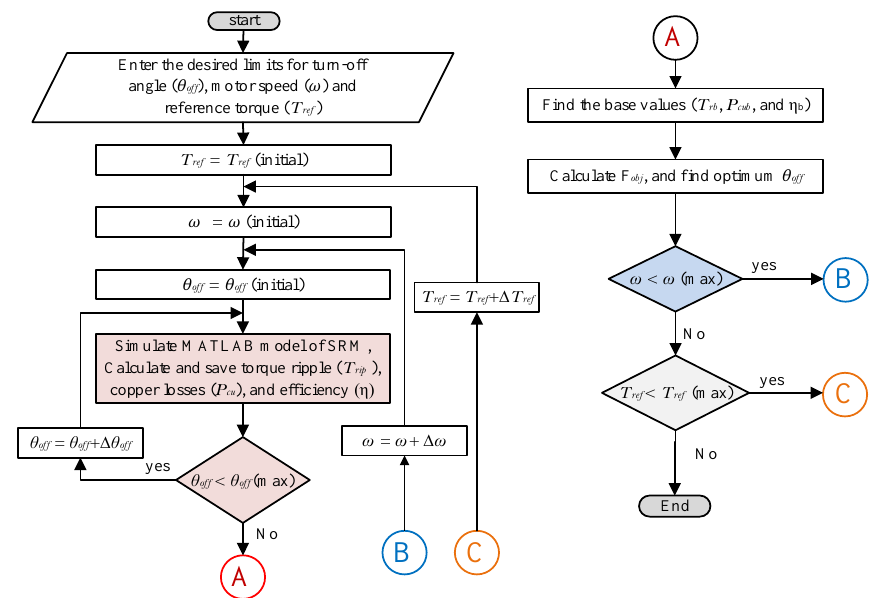
Figure 10. Flowchart of searching algorithm.